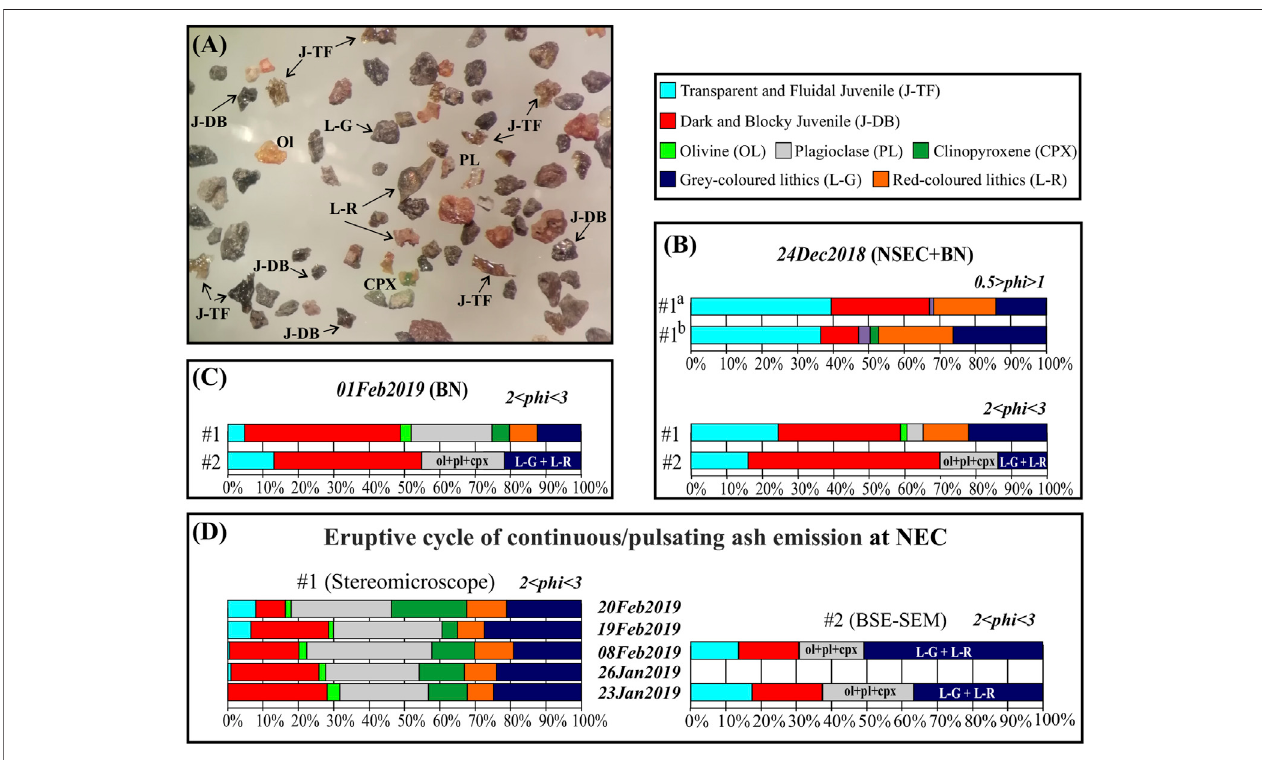
FIGURE5| Resultsofthecomponentryanalysis. (A) Viewunderthestereomicroscopeofthesamplefrom24December2018inthe2 < phi < 3sizeinterval; (B – D) histograms of frequency ofthe different components in thestudied samples [ (B) -NSEC + BN; (C) -BN; (D) -NEC] and comparison between the results obtained byusing the stereomicroscope (#1) and BSE-SEM images (#2). #1 a and #1 b correspond to results obtained with the method #1 by two different